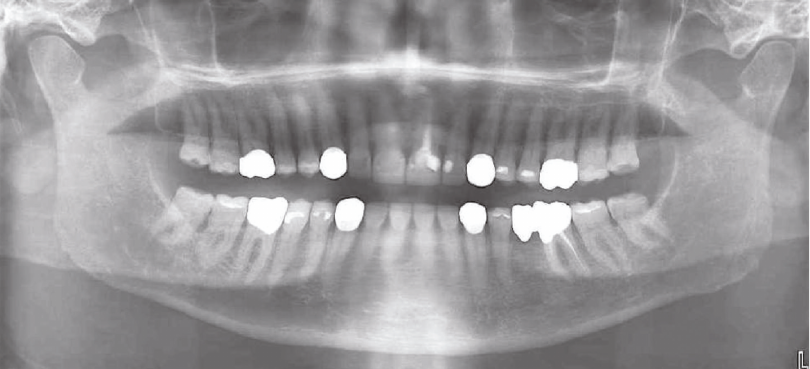
Figure 13: Final panoramic view.